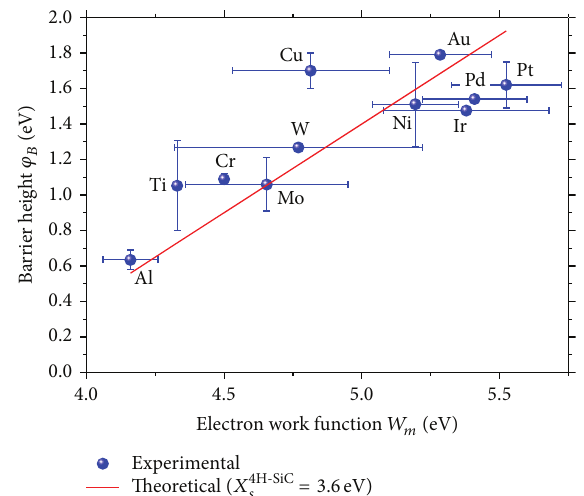
Figure 1: Experimental dependence of the barrier height 𝜑 𝐵 of metal/4H- n -SiC on the electron work function 𝑊 𝑚 of the metals [7–23]. Red curve-theoretical dependence according to the Schottky theory (the electron affinity of 4H-SiC, 𝑋 𝑠 = 3.6 eV